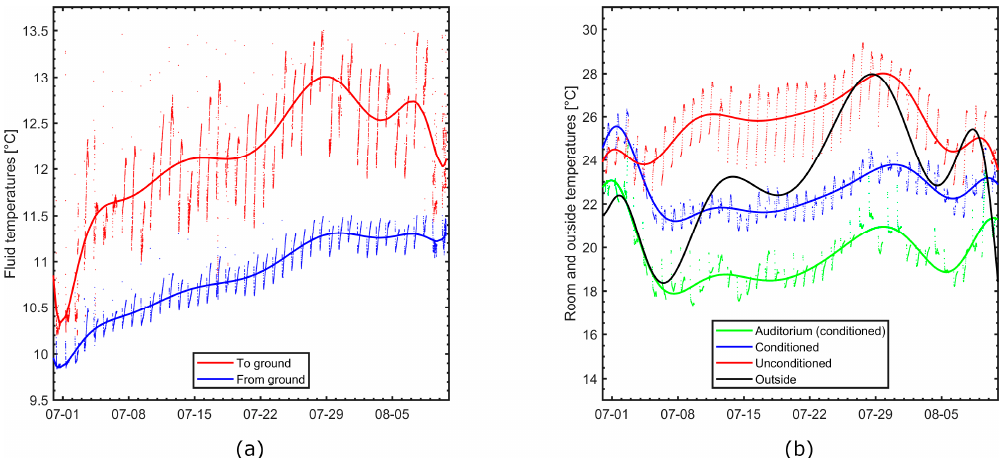
Figure 5. ( a ) Fluid temperatures to and from the piles/ground and ( b ) outside and average room temperatures. Raw data are shown as points (except highly noisy outside temperatures) while fitted, polynomial trends are drawn with full lines.